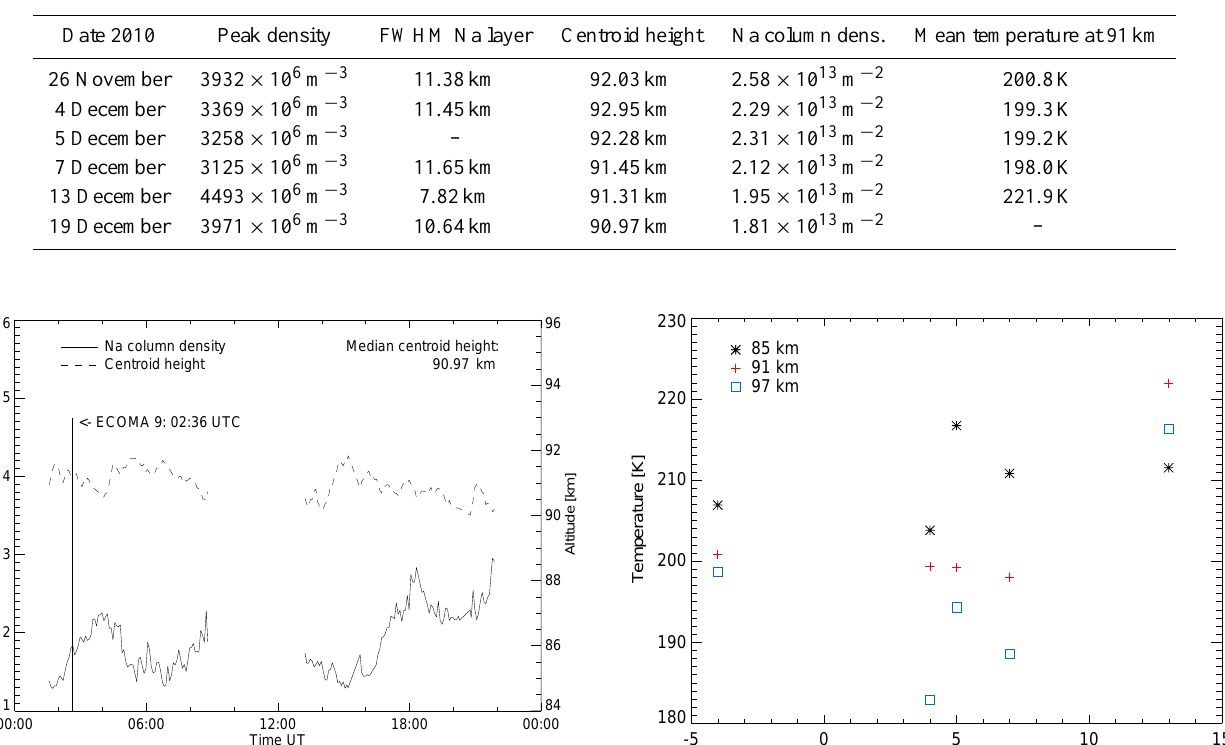
Table 3. Peak density, FWHM of the Na layer, median centroid height, median Na column density and mean temperature at 91 km of both lidar beams for days given in the left column. No FWHM of the Na layer and no temperature were calculated for 5 December and 19 December, respectively.